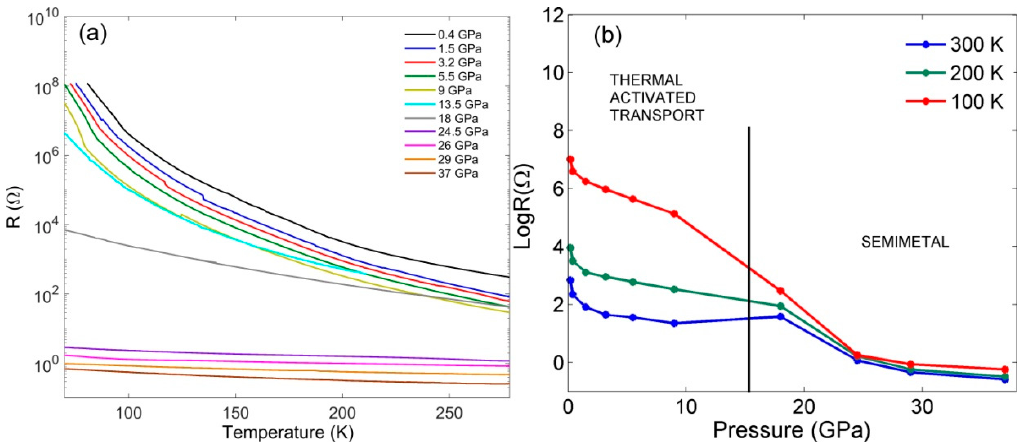
Figure 3. Electrical resistance vs. temperature of NaMn 7 O 12 for different applied pressures ( a ) and electrical resistance vs. the applied pressure at different temperatures ( b ) .